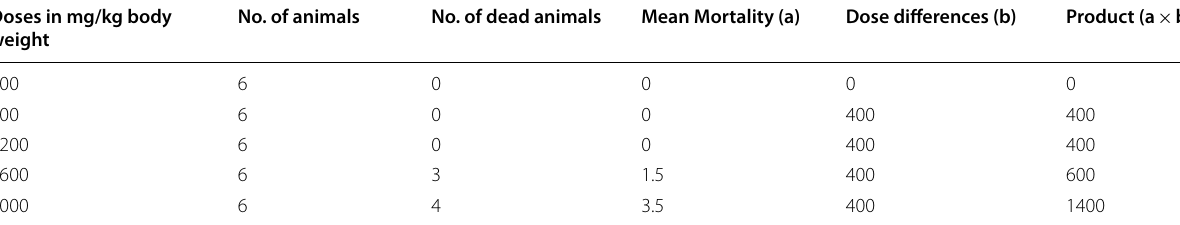
Table 7 Determination of LD50 of E. indicum (aqueous extract) Doses in mg/kg body